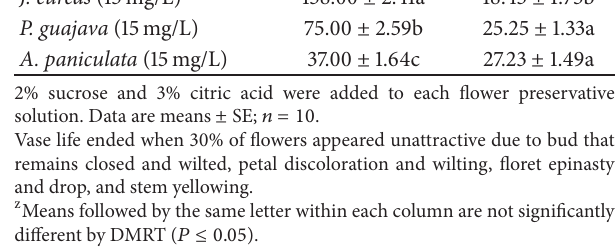
Table 5: Bacterial count and fungal growth at the end of vase life of Mokara Red orchid flowers in petri plates containing the flower preservative solution as affected by leaf extracts of Jat- ropha curcas , Psidium guajava, and Andrographis paniculata and 8- hydroxyquinoline citrate (8-HQC).